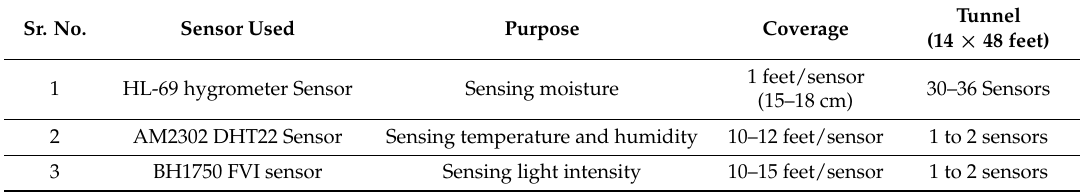
Table 3. Design statistics of a 14 × 48 tunnel farm.